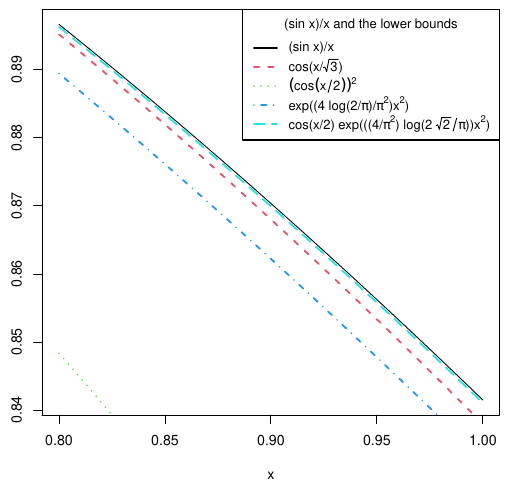
Figure 1. Visual comparison of lower bounds for (sin x ) /x with x ∈ [0 . 8 , 1] ; the obtained lower bound is in lightblue color